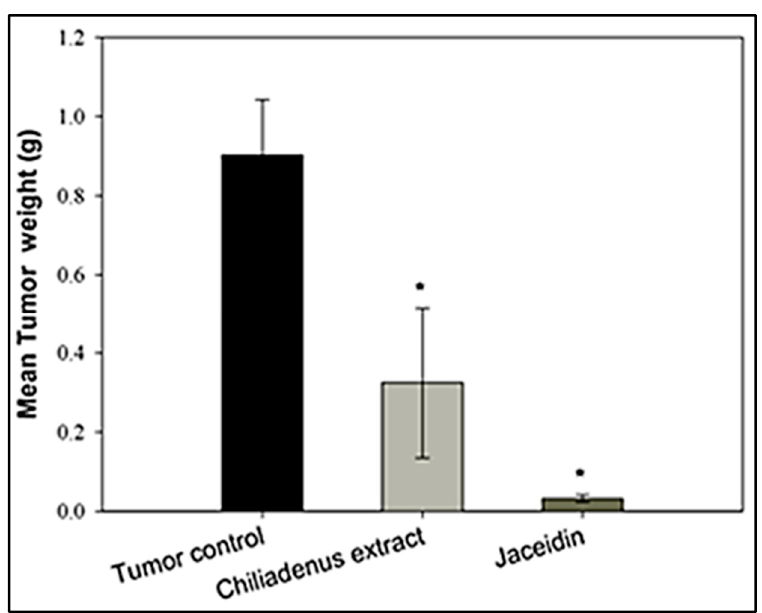
Figure 2. Effect of Chiliadenus montanus extract and Jaceidin on weight on Ehrlich’s ascites carcinoma solid tumors growing in female mice. Data are expressed as the mean ± SD and analyzed using one-way ANOVA followed by Bonferroni’s post-hoc test. * compared to the tumor control group at p < 0.05.